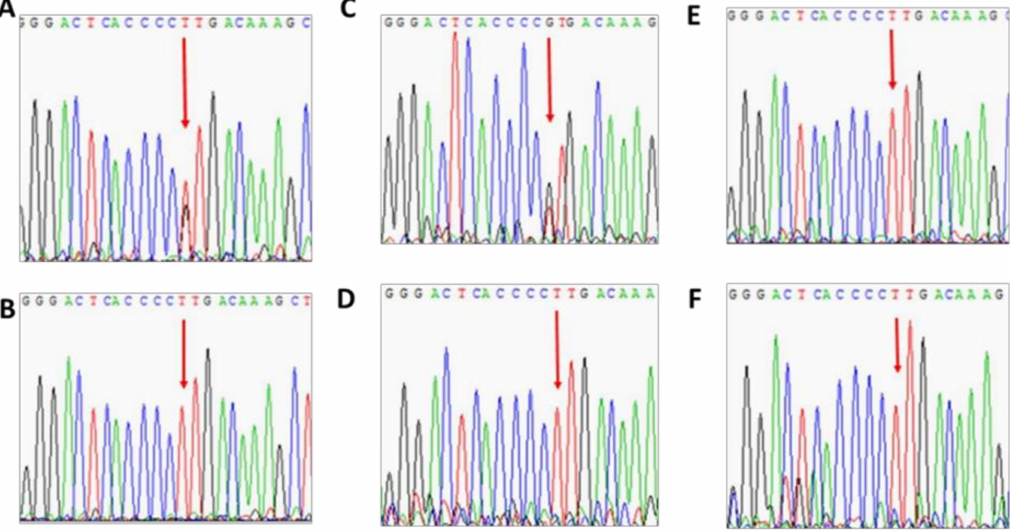
Figure 3. Analysis of family members of patient 2 for the SYTL4 mutation c.1655A > C. ( A )—patient 2, ( B )—father,